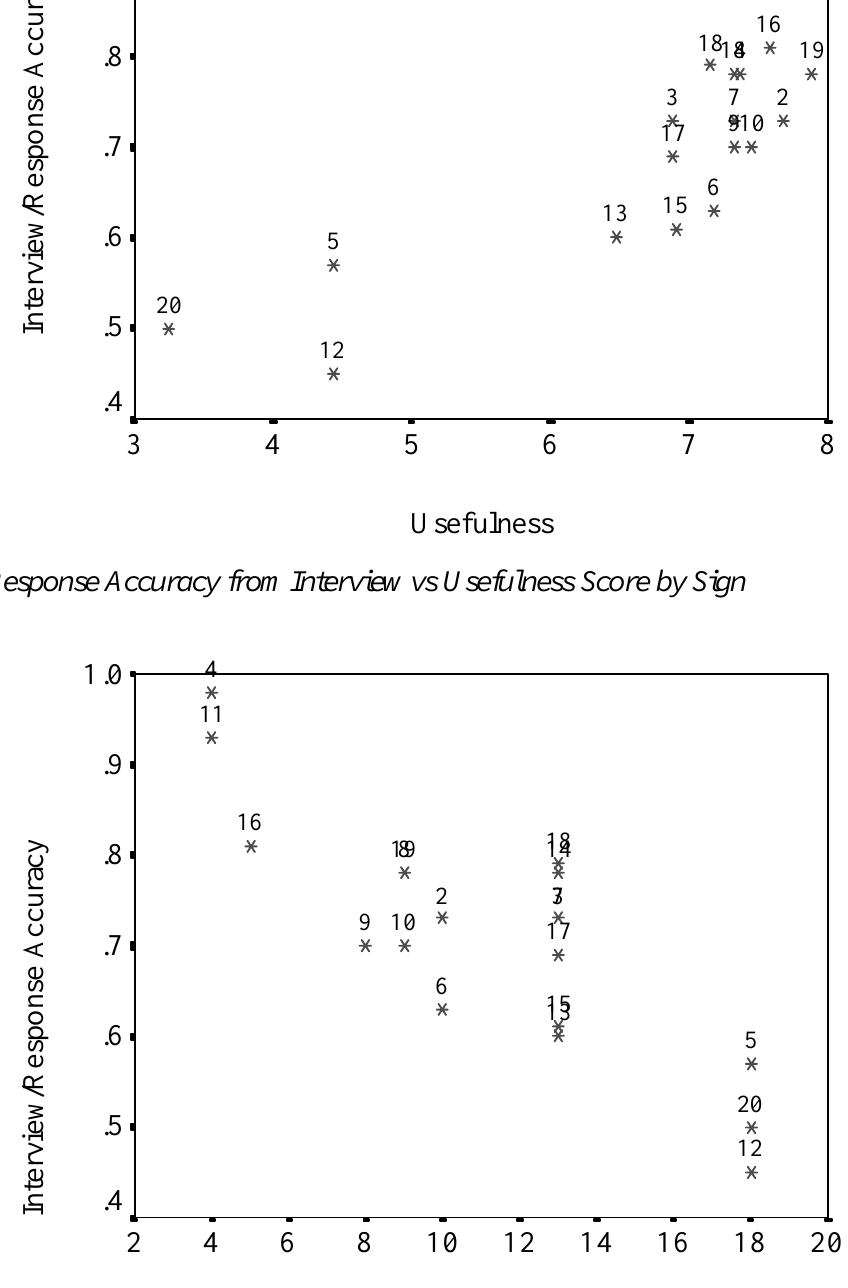
Information Units Figure 6b. Accuracy of Response vs Information Units by